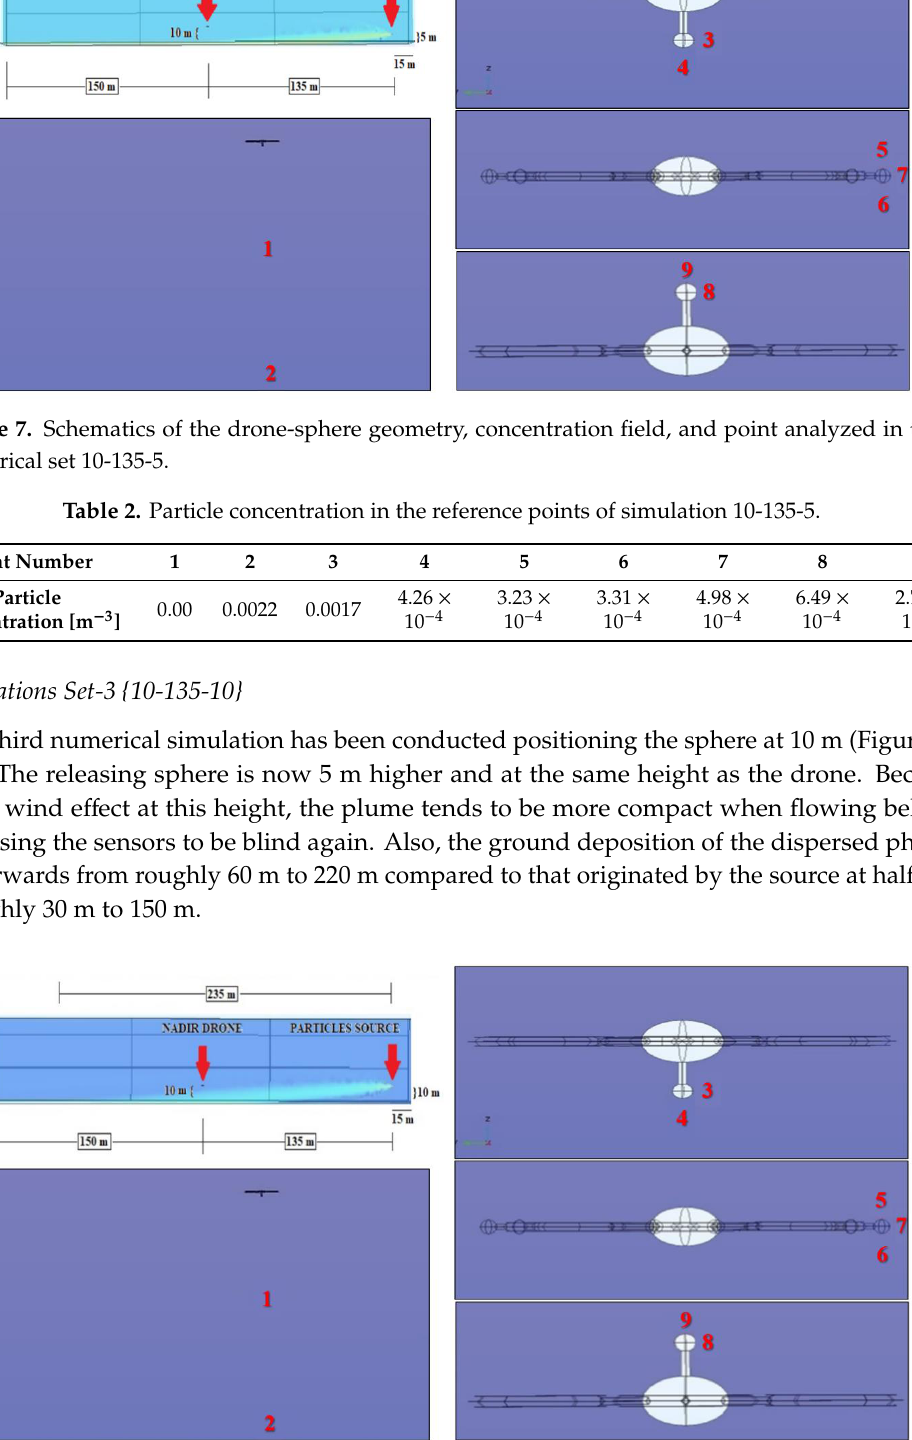
Table 3. Particle concentration in the reference points of simulation 10-235-10.